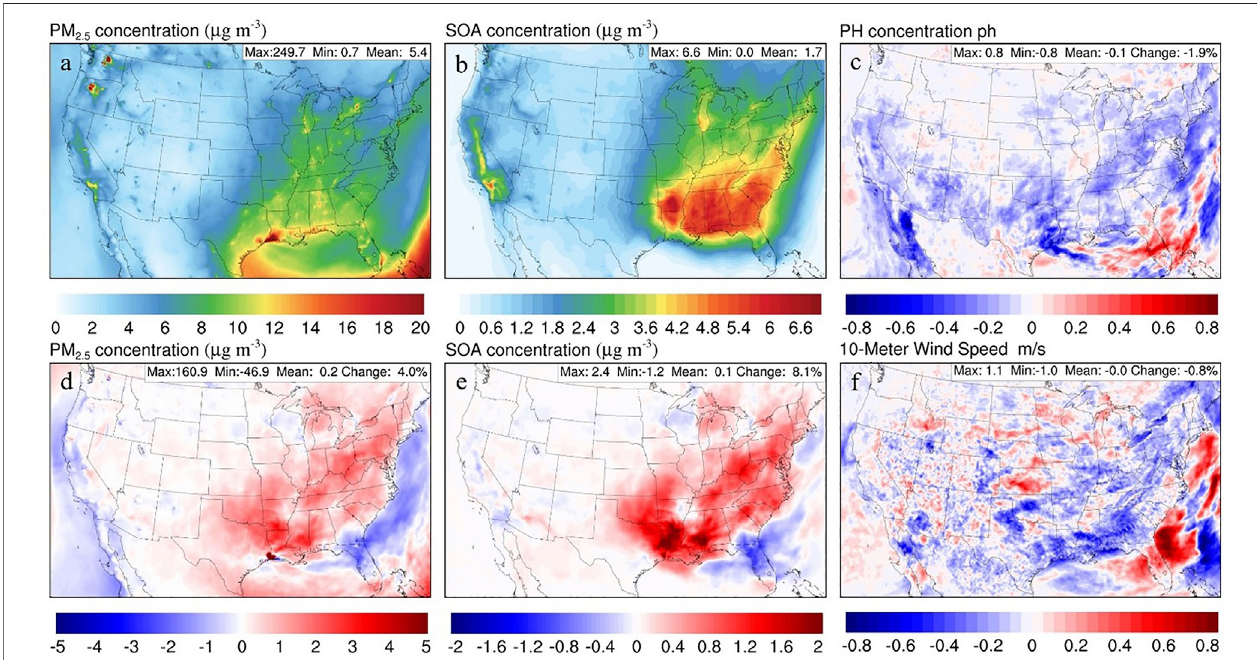
FIGURE 4 | Spatial distribution of time-averaged concentration for Base_14 (A) PM 2.5 and (B) SOA. Spatial distribution of differences between UpTk_14 and Base_14 uptake case: (D) PM 2.5 , (E) SOA, (C) pH, and (F) 10-metter wind speed.